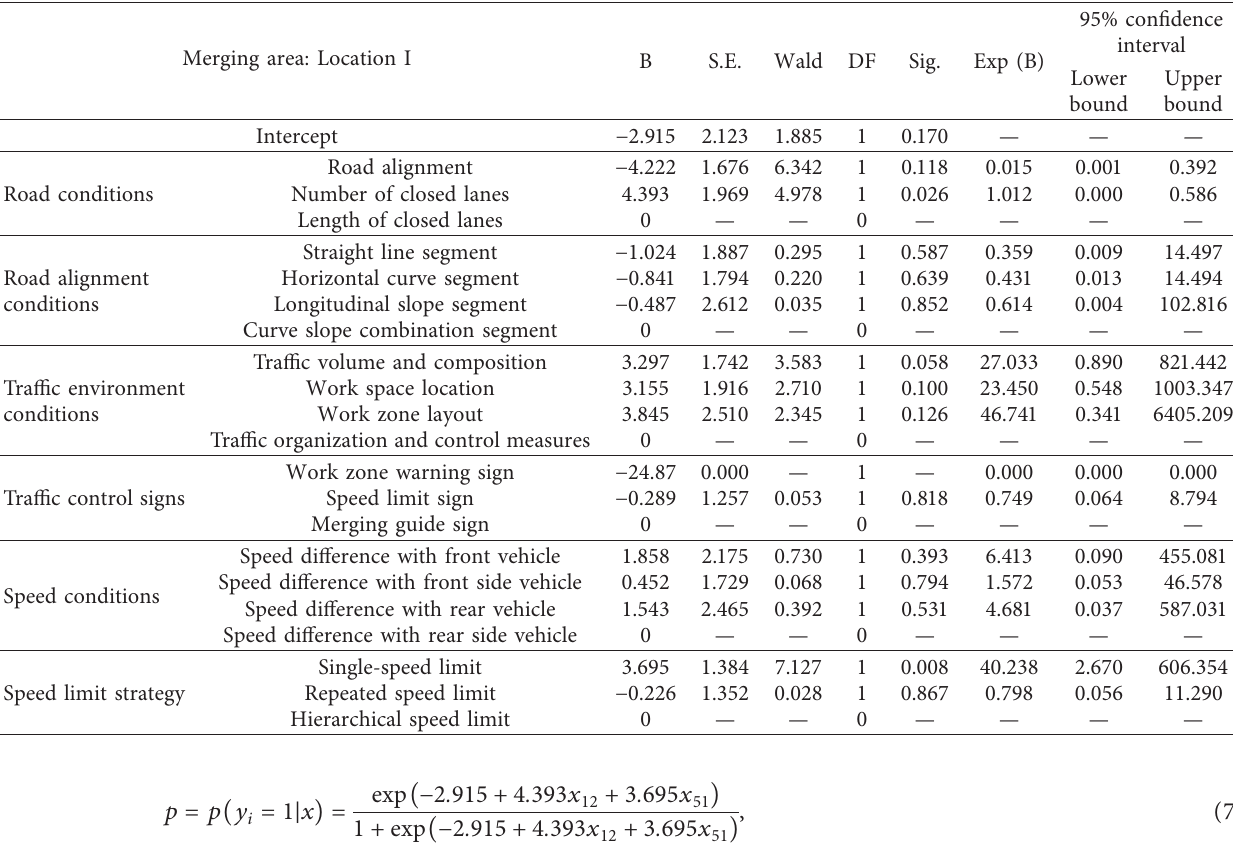
Table 4: Logistic regression model estimation results for Location Ι